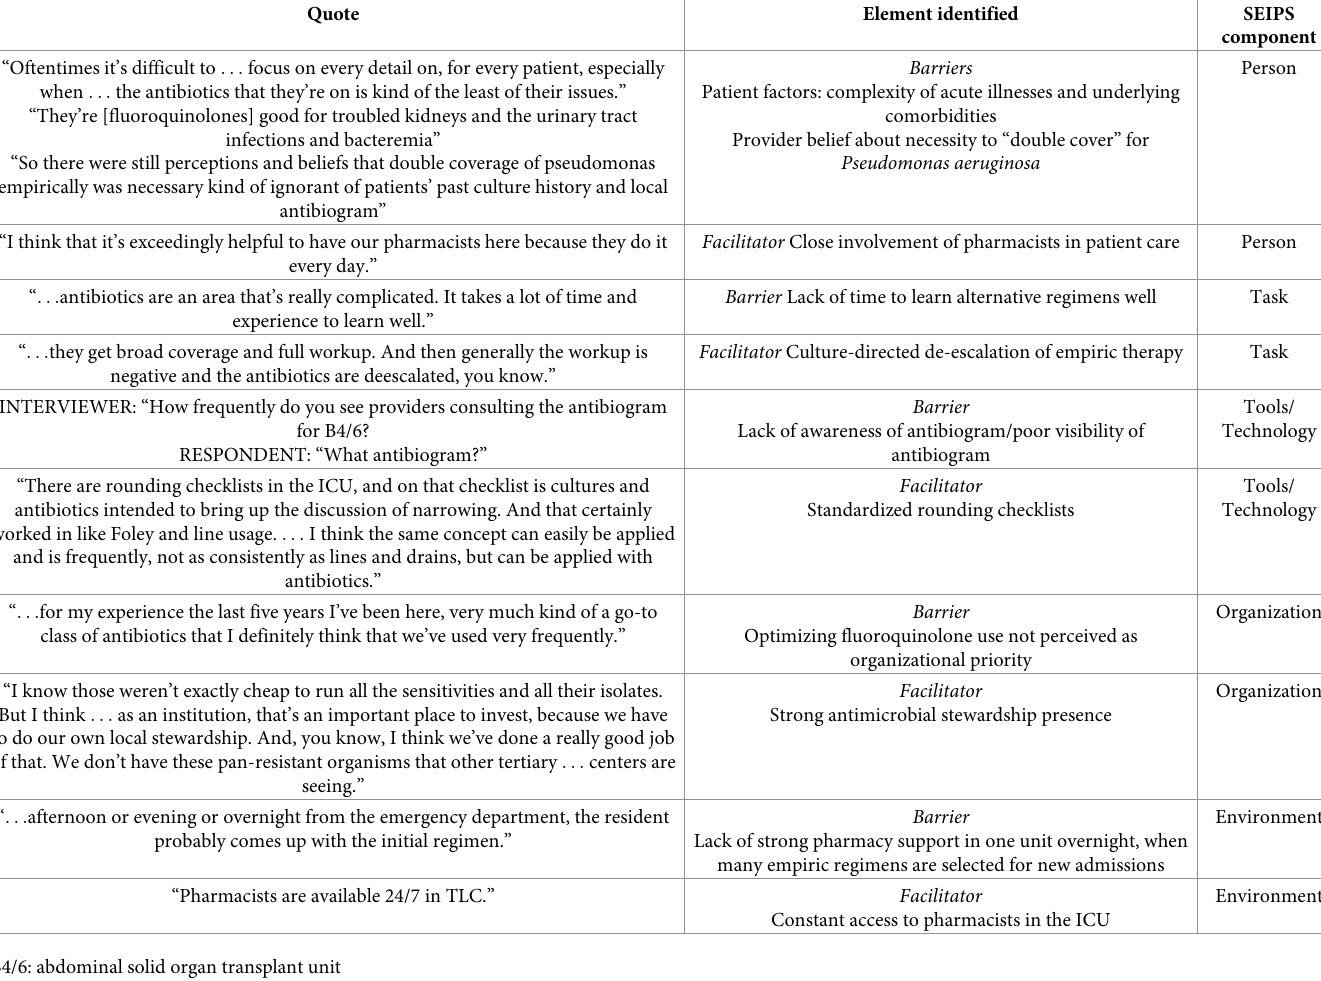
Table 5. Barriers and facilitators to fluoroquinolone prescribing optimization, coded by Systems Engineering Initiative for Patient Safety (SEIPS) framework com- ponent with illustrating provider